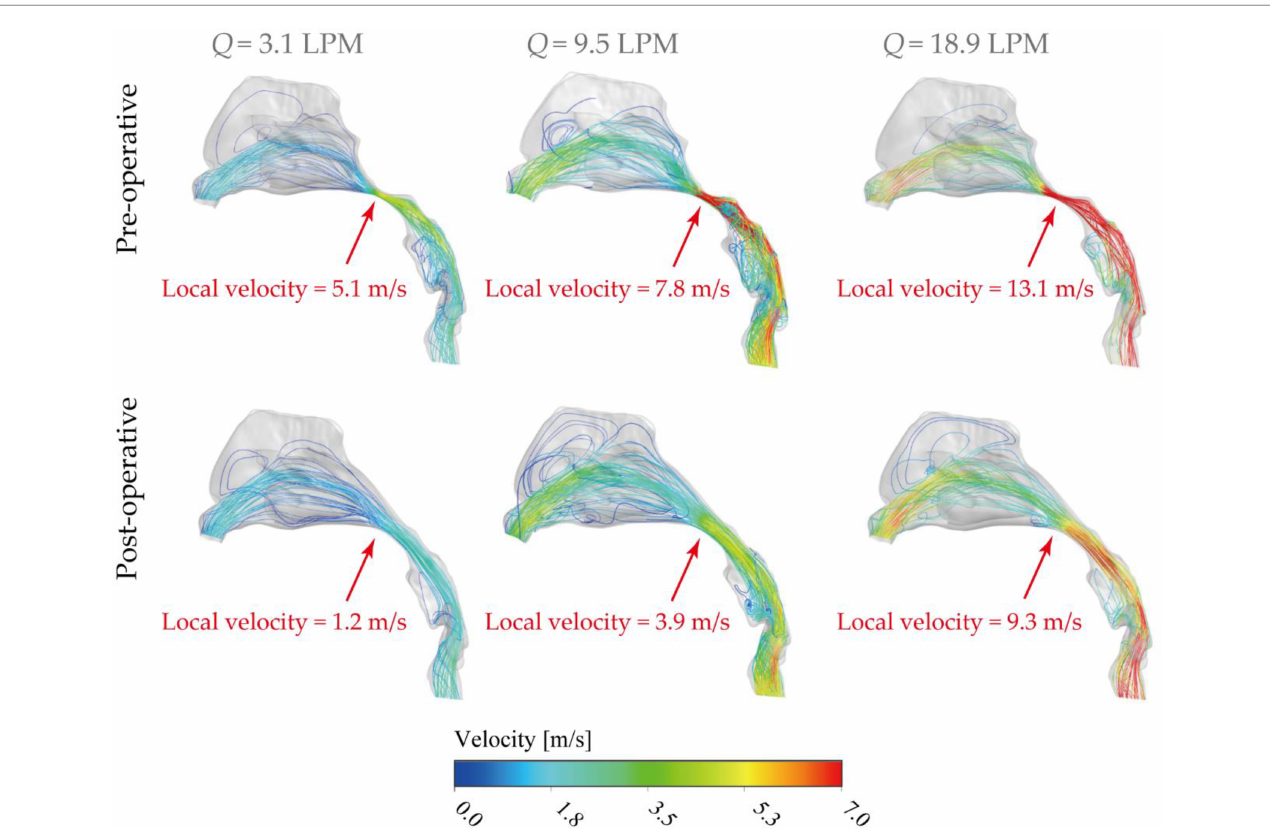
FIGURE 7 Lateral view of velocity streamlines [m/s] pre- and post-operative under inhalation fl ow rates of 3.1 LPM, 9.5LPM and 18.9LPM Nasal, with local nasopharyngeal peak velocity highlighted in the fi gure.